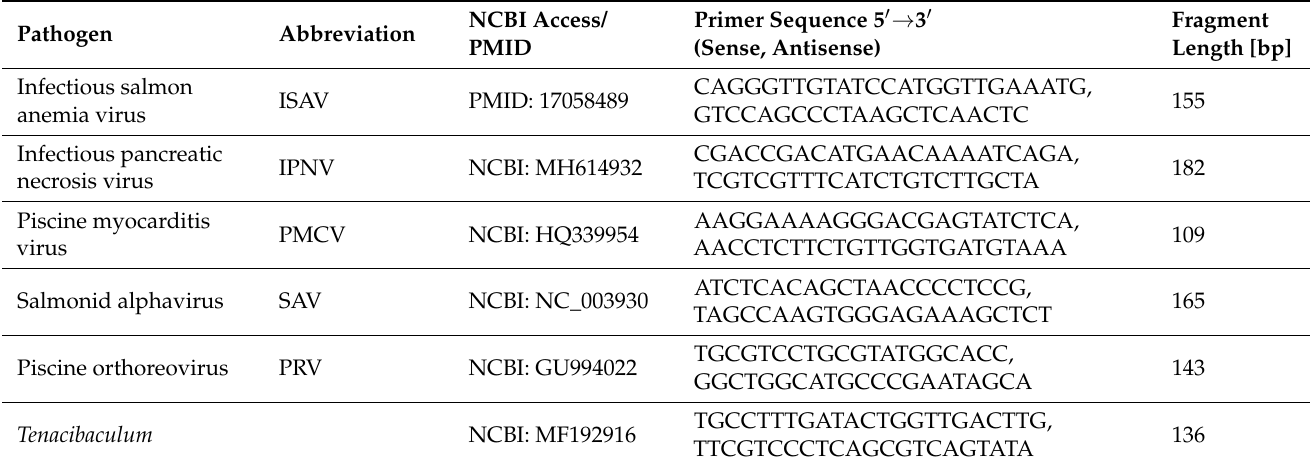
Table 1. Primers for viral and bacterial